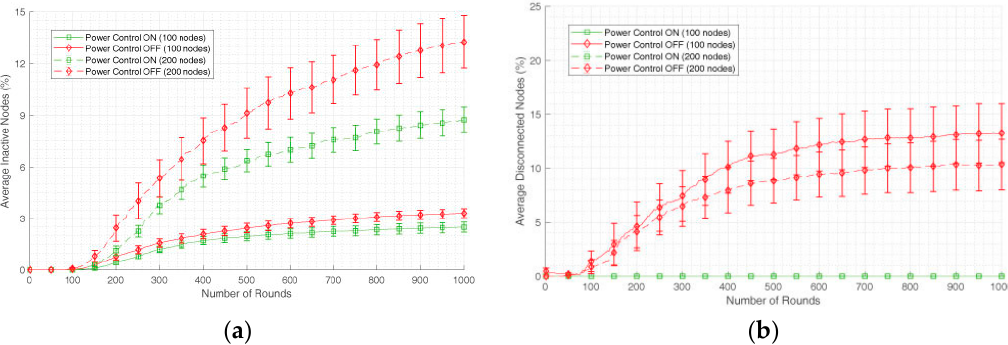
Figure 2. Network performance in terms of ( a ) number of inactive nodes and ( b ) number of disconnected nodes.